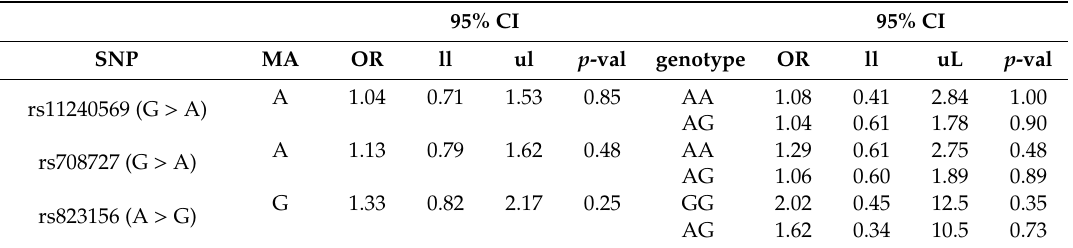
Table 3. Odds ratios of minor alleles and genotypes containing minor allele at particular A1 SNPs. 95% CI 95% CI SNP MA OR ll ul p -val genotype OR ll uL p -val A 1.04 rs11240569 (G > A)